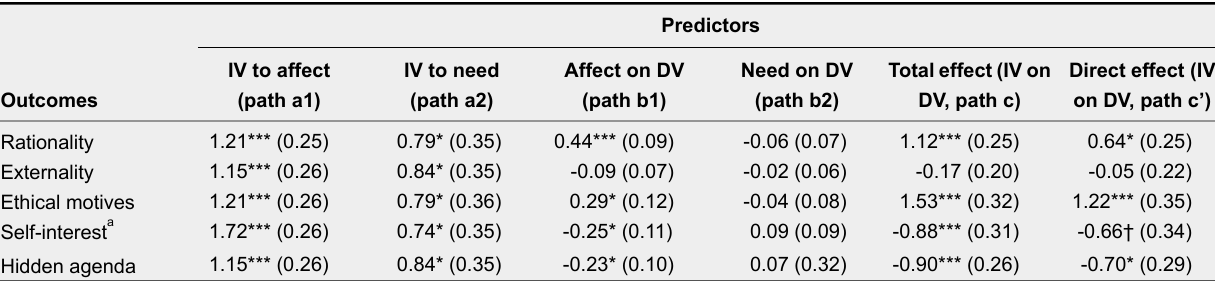
Unstandardized Regression Coefficients and Standard Errors (in Parentheses) for all Effects in the Mediation Analyses Using Position, Need for Justification and Affect as Predictors of Biases (Study 3, N =